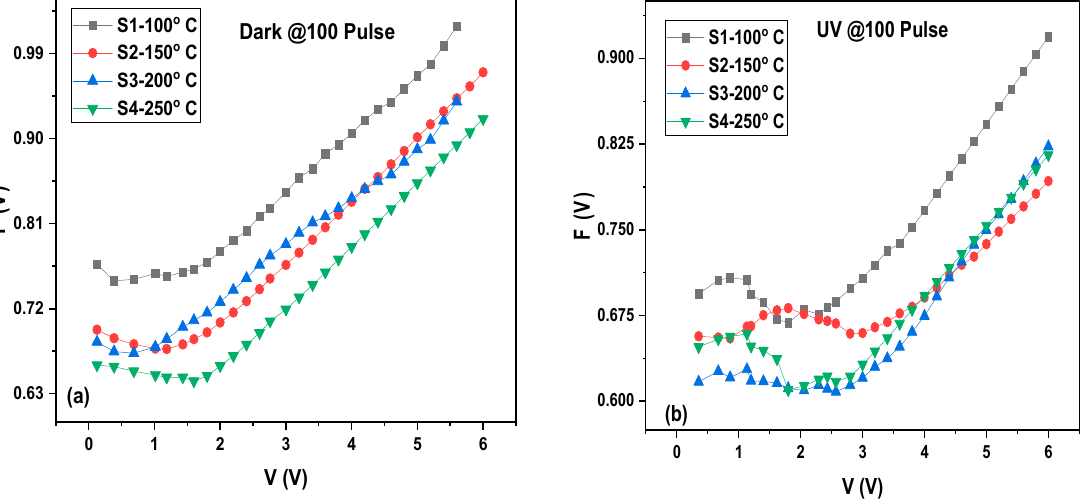
Figure 11. F (V) vs. Voltage of MoO 3 /Si heterostructure photodetector at di ff erent depositing temperatures for dark (a) and UV irradiance (b). The barrier height, series resistance, and ideality factor ( n ) for the MoO 3 /Si heterostructure photodetector were calculated and are presented in Tables 1 and 2. The observed variation in the ideality factor ( n ) can be a tt ributed to the e ff ects of the series resistance, which causes a voltage drop across the interfacial thin fi lm and the charge of the interface states with the bias in the low voltage region of the I–V diagram. Both the R s and R sh values have considerable in fl uence on many electronic devices. The experimental R s and R sh values are determined by plo tt ing the structure resistance (R i ) vs. applied bias voltage (V) as shown in Figure 12. It has been observed that at a high forward bias voltage, the R s designates a nearly constant value for positive voltages greater than 0.5 V for all thicknesses. Subsequently, at a negative bias voltage, the value of R i becomes constant for all thicknesses that correspond to R sh . The transportation of charge carriers through the di ff usion layer or the enhanced tunneling current through the barrier high using heavy- doped n -type Si can cause a lower value for the series resistance R s [53].